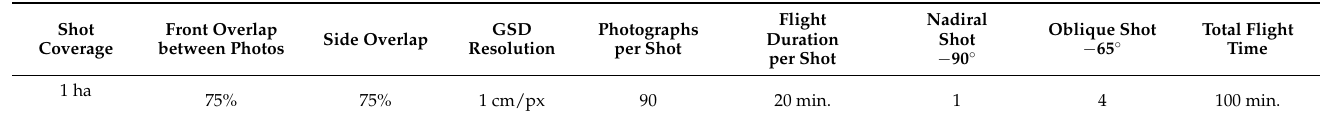
Figure 9. Automatic flight configuration for a surface of 1 ha in the UNAV university campus in Pamplona: ( a ) UAV shots and Gimbal inclinations; ( b ) data in the DJI-GS Pro app. Table 1. Automated flight configuration chart for the coverage of a 1 ha area and with photogram- metric model resolution of 1 cm/pixel.